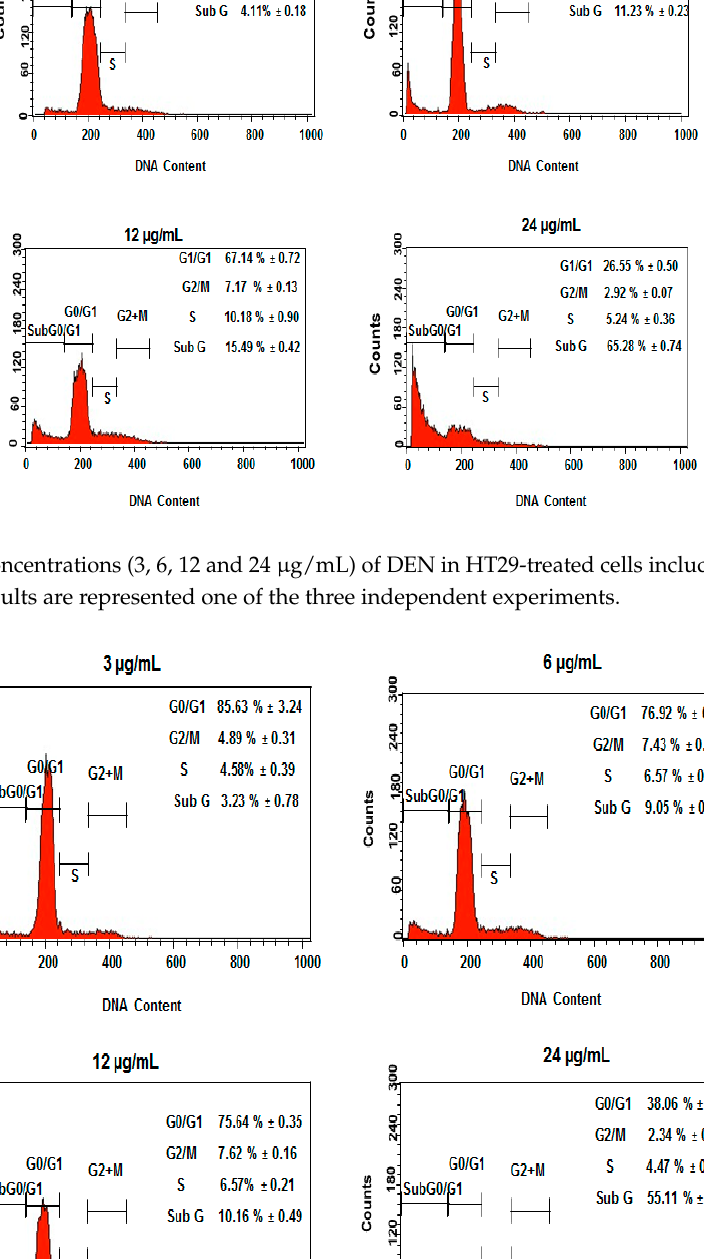
Figure 9. The concentrations ( 3, 6, 12 and 24 µg/ml) of DEN-HP β CD complex in HT29-treated cells included G2/M cell cycle arrest. Results are represented one of the three independent experiments.